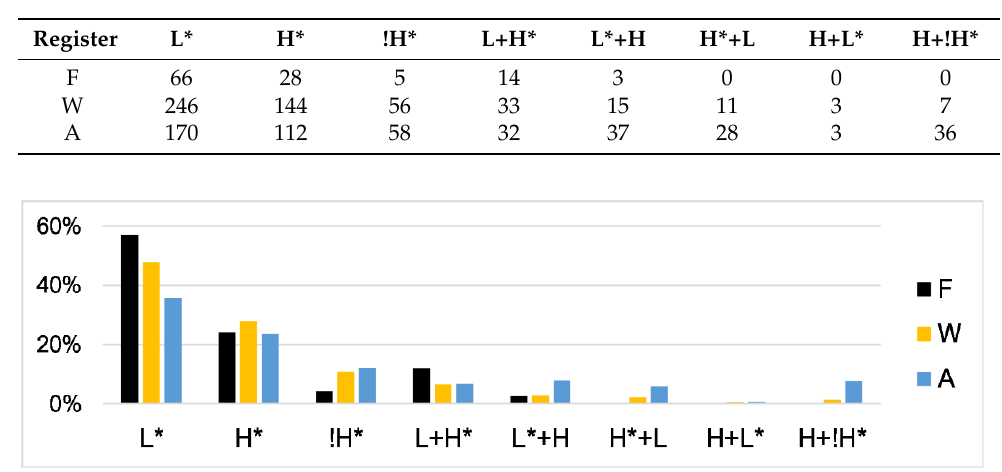
Figure 5. Observed pitch accent types as a percentage of total pitch accent tokens, by register.